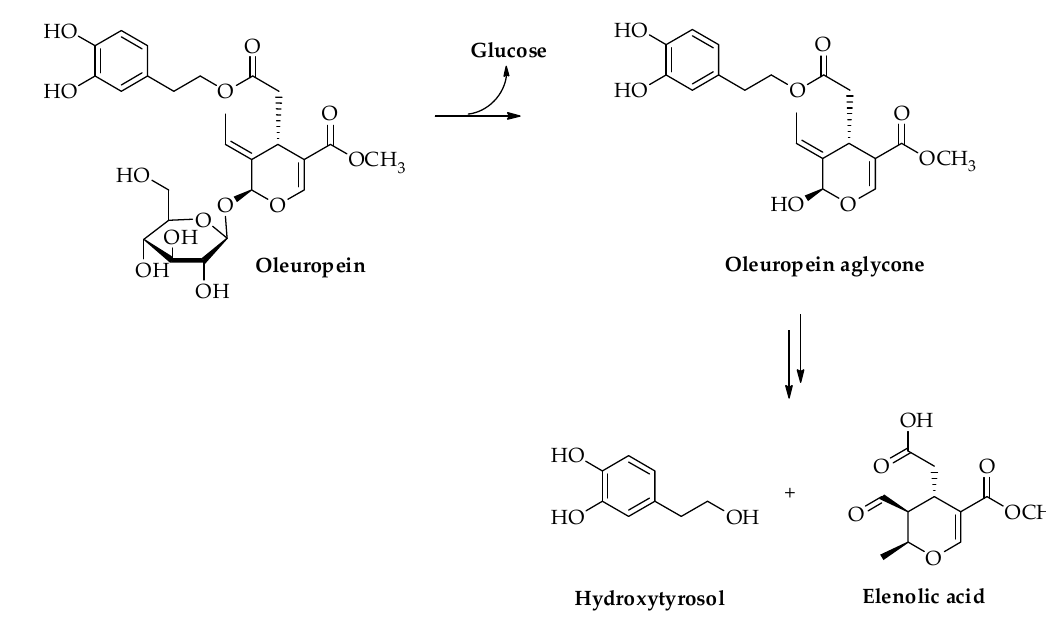
Figure 2. Enzimatic conversion of oleuropein into hydroxytyrosol.